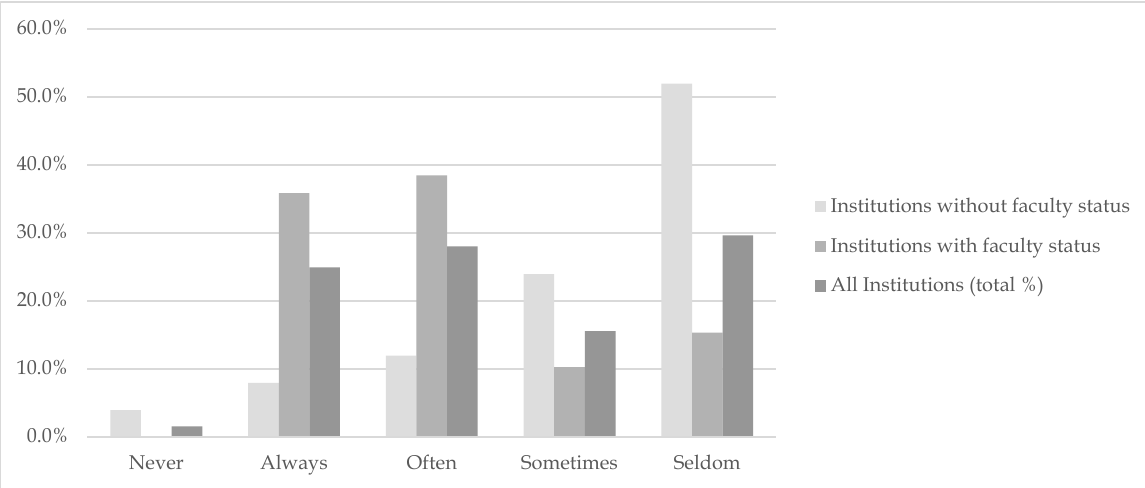
Figure 2 Librarians at my institution are active in conducting scholarly research